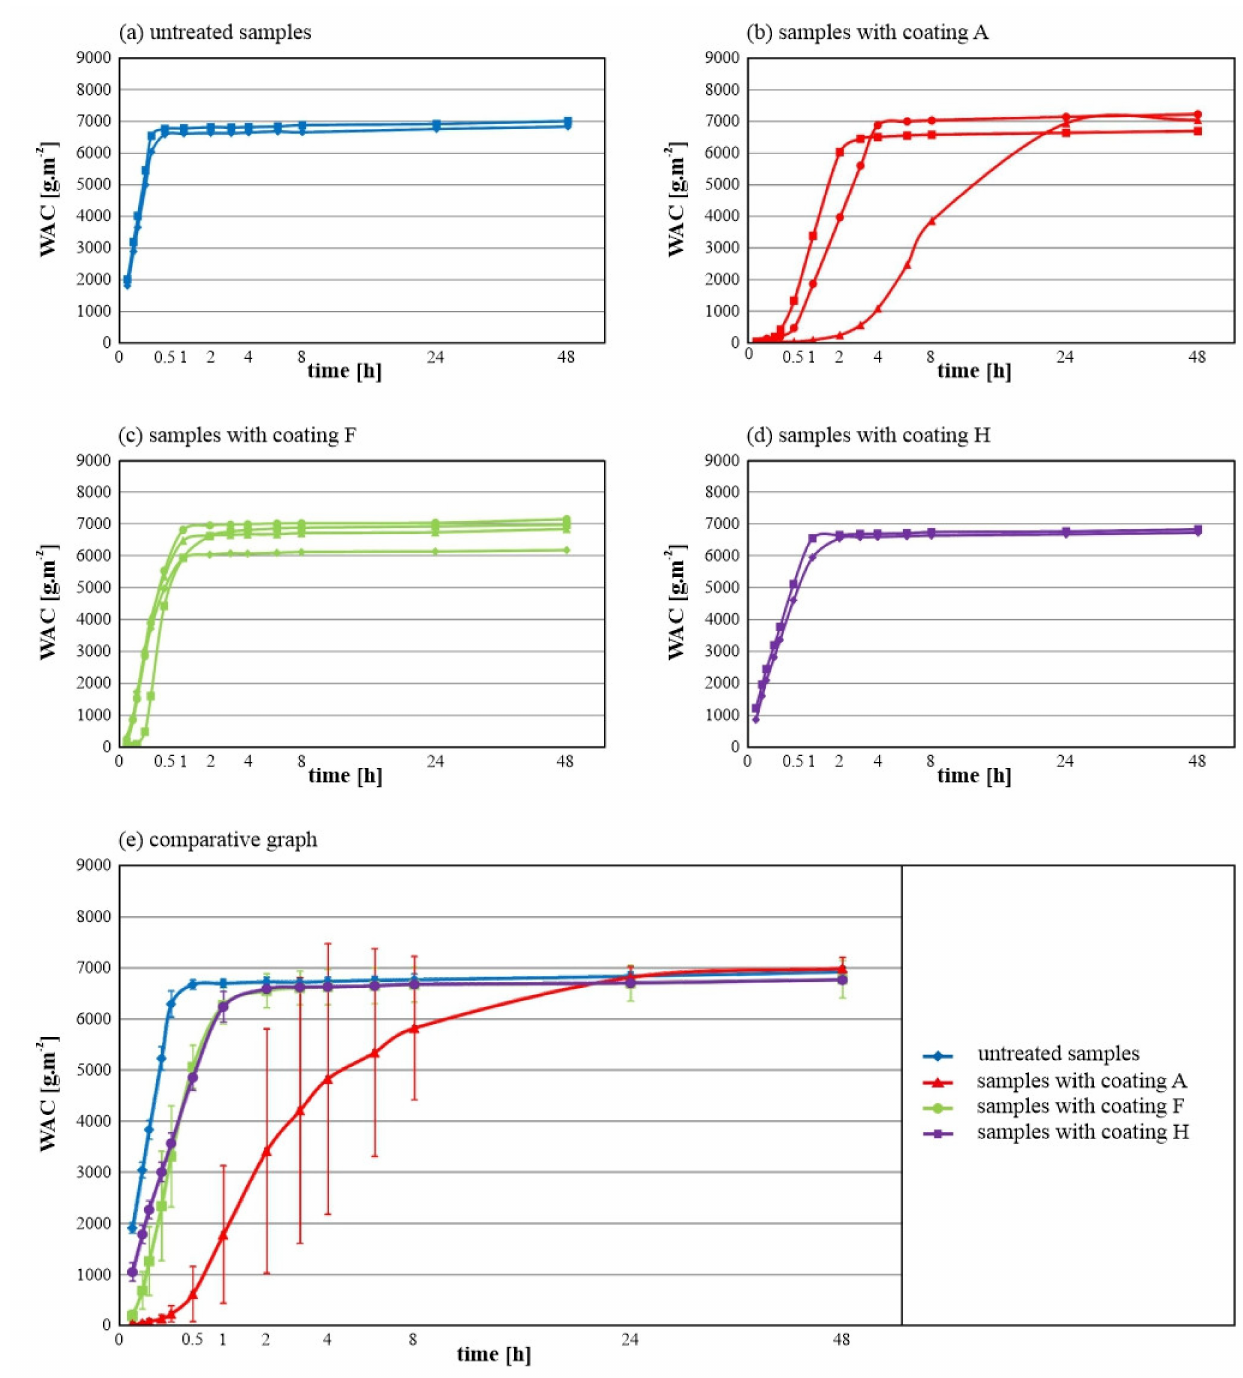
Figure 5. Curves of water absorption by capillarity—MS, ( a ) is for untreated samples, ( b ) is for samples with coating A, ( c ) is for samples with coating F, ( d ) is for samples with coating H and ( e ) is comparative